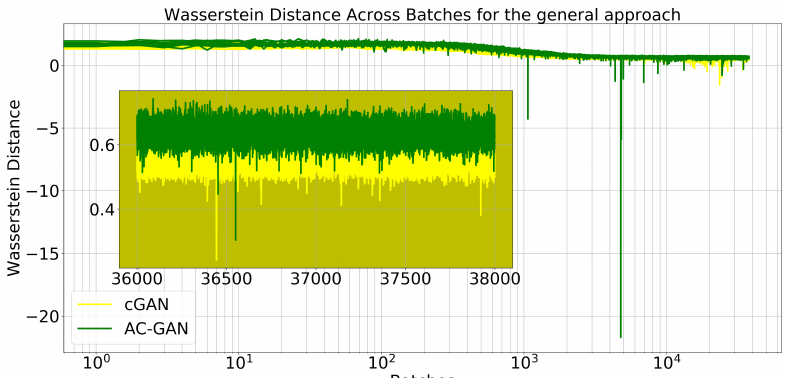
Figure 13. Training curves for the general approach for the LORO-based cross-validation. As it is depicted, not only the training phases converged for every fold but it converged to values close to the ones found by the expert WGAN approach.